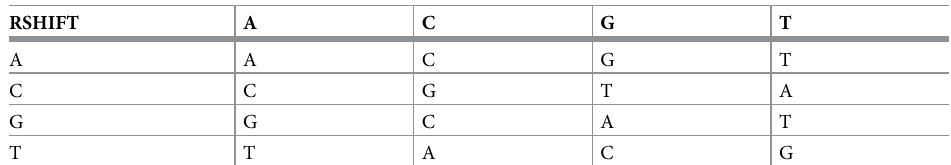
Table 9. DNA shift right.